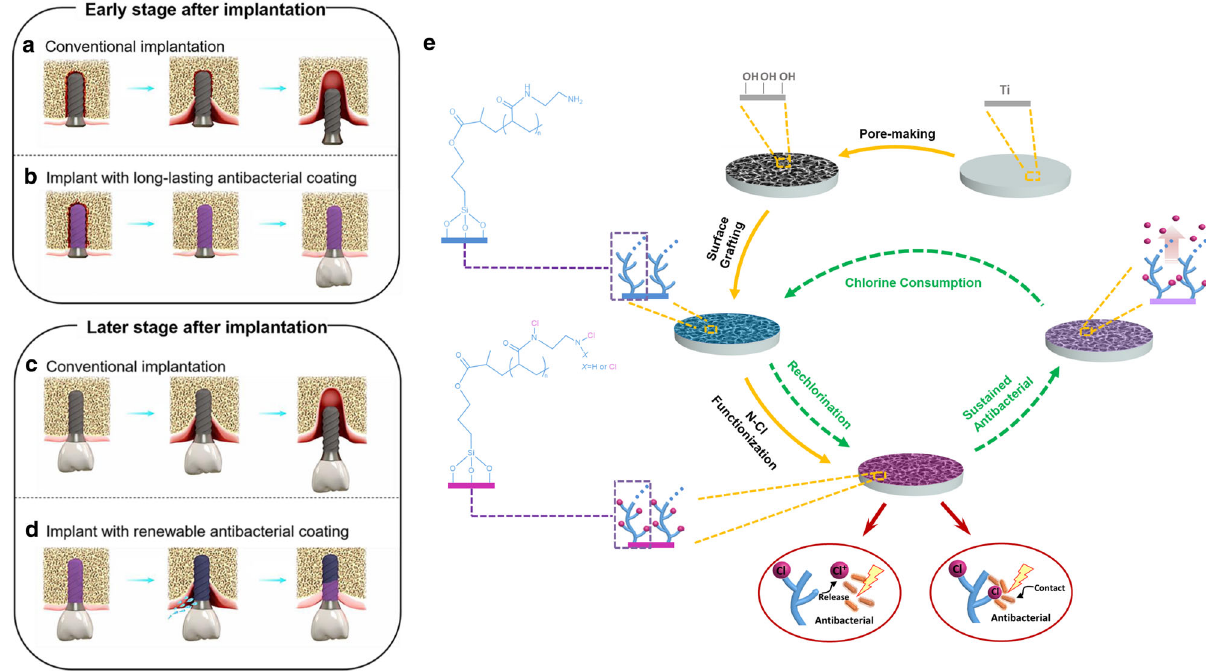
Fig. 1 Schematic illustration about how the porous N-halamine polymeric coating on the titanium surface prevents and treats peri-implant infection. a Early loss of the implant is easily caused by bacterial invasion prior to the formation of osseointegrated interface. b Long-lasting antibacterial property of N-halamine polymeric coating guarantees an effective antibacterial protection to prevent the early peri-implant infection and improve the success rate of dental implantation in the early stage. c Once the peri-implantitis occurs at the later stage, it is very dif fi cult to reverse, ultimately resulting in the loss of the dental implant. d After being consumed, if peri-implantitis occurs, the antibacterial component of N-halamine polymeric coating can be simply regenerated by peri-implant irrigation, and the exposed implant surface will regain antibacterial property to resist bacterial invasion and control peri-implantitis. e Chemical synthesis process and antibacterial mechanism of the porous N-halamine polymeric coating on the titanium